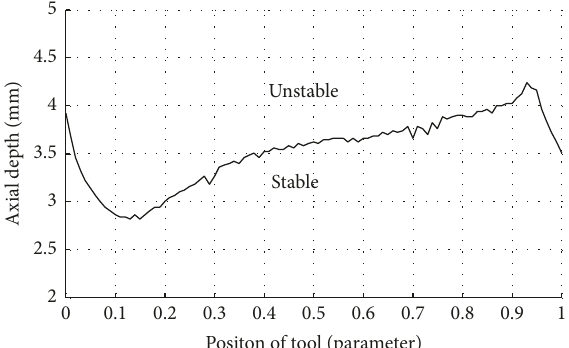
Figure 7: Maximum axial cutting depth versus tool